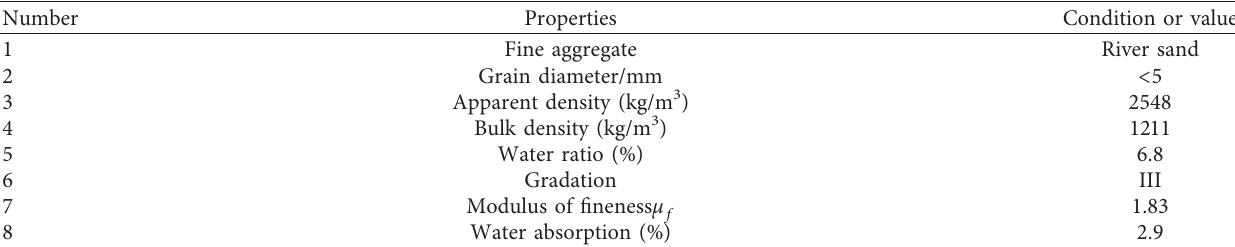
Table 2: Main properties of fine aggregate.